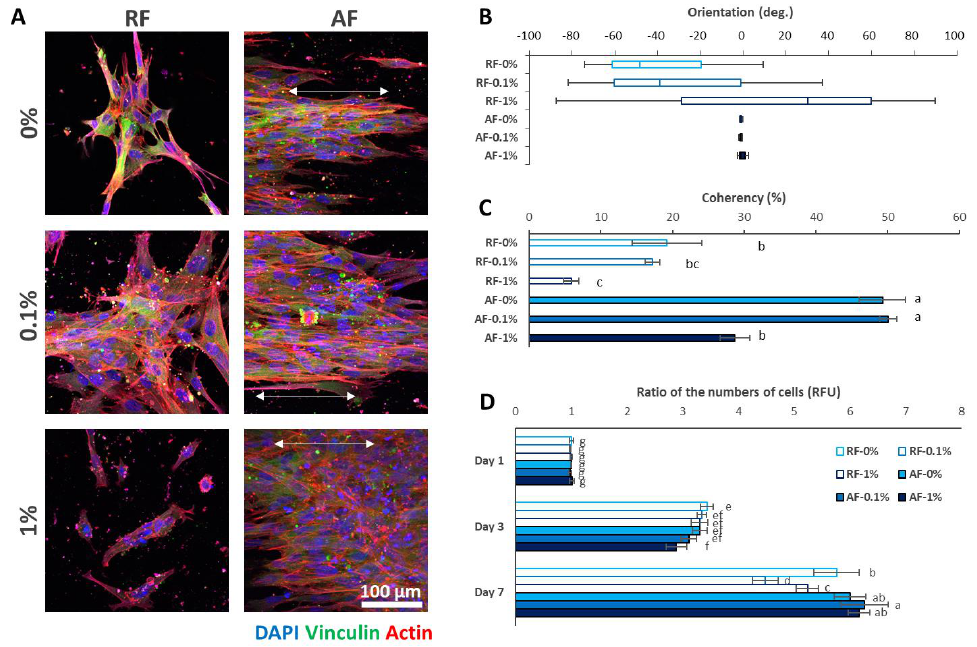
Figure 2. Effects of the RGO-PCL NFs on DPSC behavior. ( A – C ) Analyses of cellular morphologies. ( A ) Immunocytochemistry (ICC) results 2 days after seeding. Corresponding with the NF alignments, the DPSCs on the RFs were randomly aligned, whereas those on the AFs were aligned well. In particular, vinculin, an indicator of focal adhesion, did not stain the cells on the 1% RGO-PCL NFs, which indicated that excessive RGO incorporation may be harmful to initial cell adhesion. ( B ) DPSC alignments. Corresponding to the RGO-PCL NFs, the cells on the RFs showed broad orientation, whereas those on the AFs showed narrow orientation. ( C ) Coherency of the DPSC alignments. The alignments of the DPSCs on AFs were significantly higher than those of cells on the RFs, except for AF-1%. Furthermore, the cells on NFs with high RGO incorporation (1%) showed significantly decreased coherency. Error bars indicate the standard deviation. Same alphabets mean a non-significant difference between samples ( p < 0.05). ( D ) Ratio of the numbers of DPSCs on the RGO-PCL NFs. On day 3, cells on AF-1% showed significantly decreased viability. On day 7, cells on AF-0.1% showed significantly higher viability, whereas those on RF-0.1% and RF-1% showed significantly lower viability. Error bars indicate the standard deviation. Same alphabets mean a non-significant difference between samples ( p < 0.05).